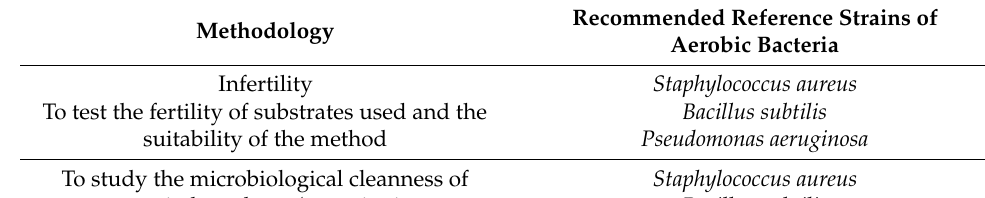
Table 1. Standard strains recommended in microbiological methods.